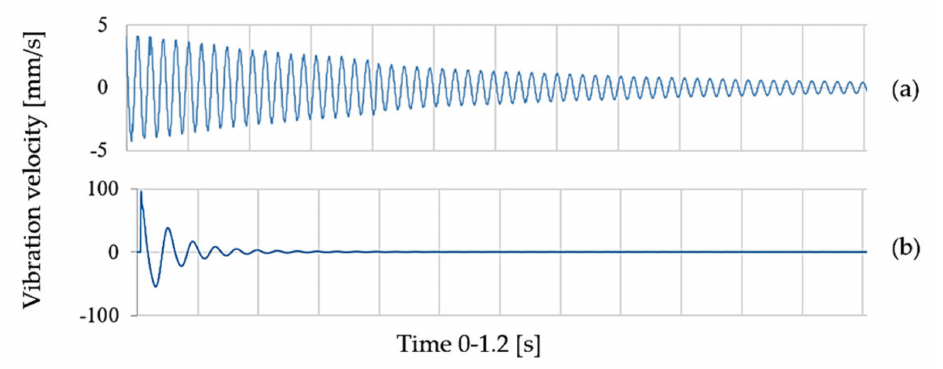
Figure 12. Time-domain-response curves: ( a ) multilayered laminates, and ( b ) particle